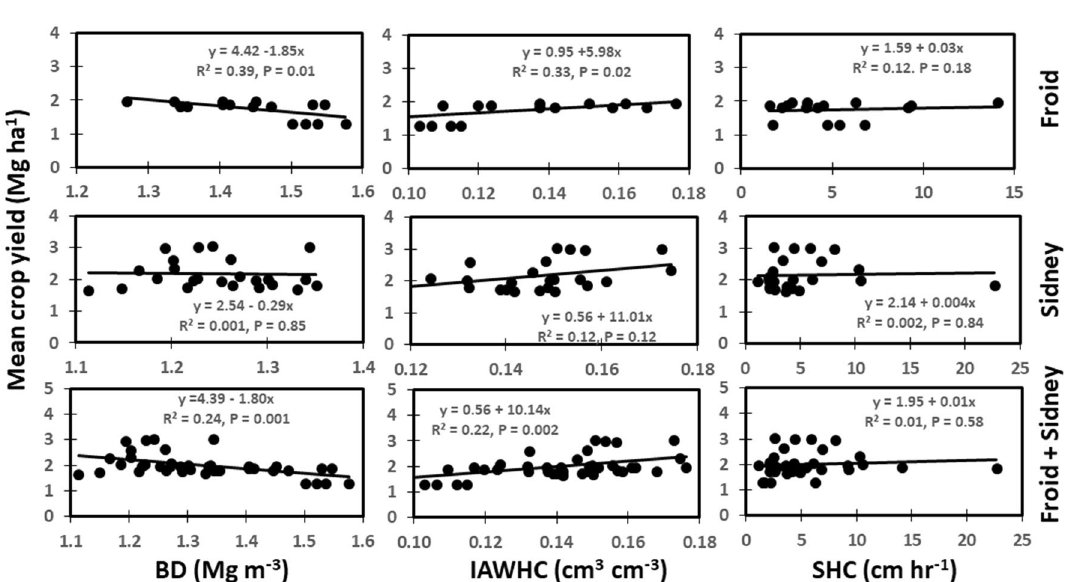
Figure 5. Relationships among soil bulk density (BD), intact core available water capacity (IAWHC), saturated hydraulic conductivity (SHC), and mean crop yield across years at Froid, Sidney, and the combined data from Froid and